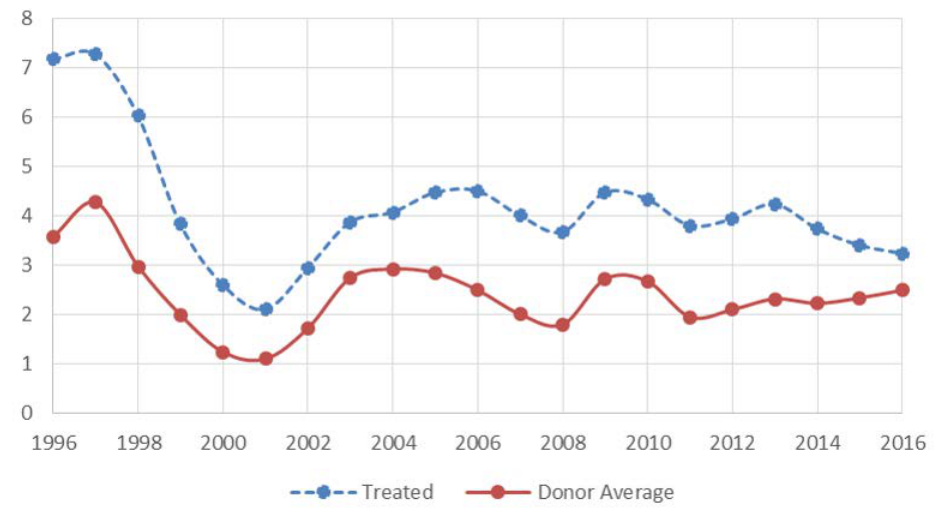
Figure 3. Unemployment rates (SECO) of Ticino (treated) and weighted average (by employees) of the donor pool. Second quarter of the